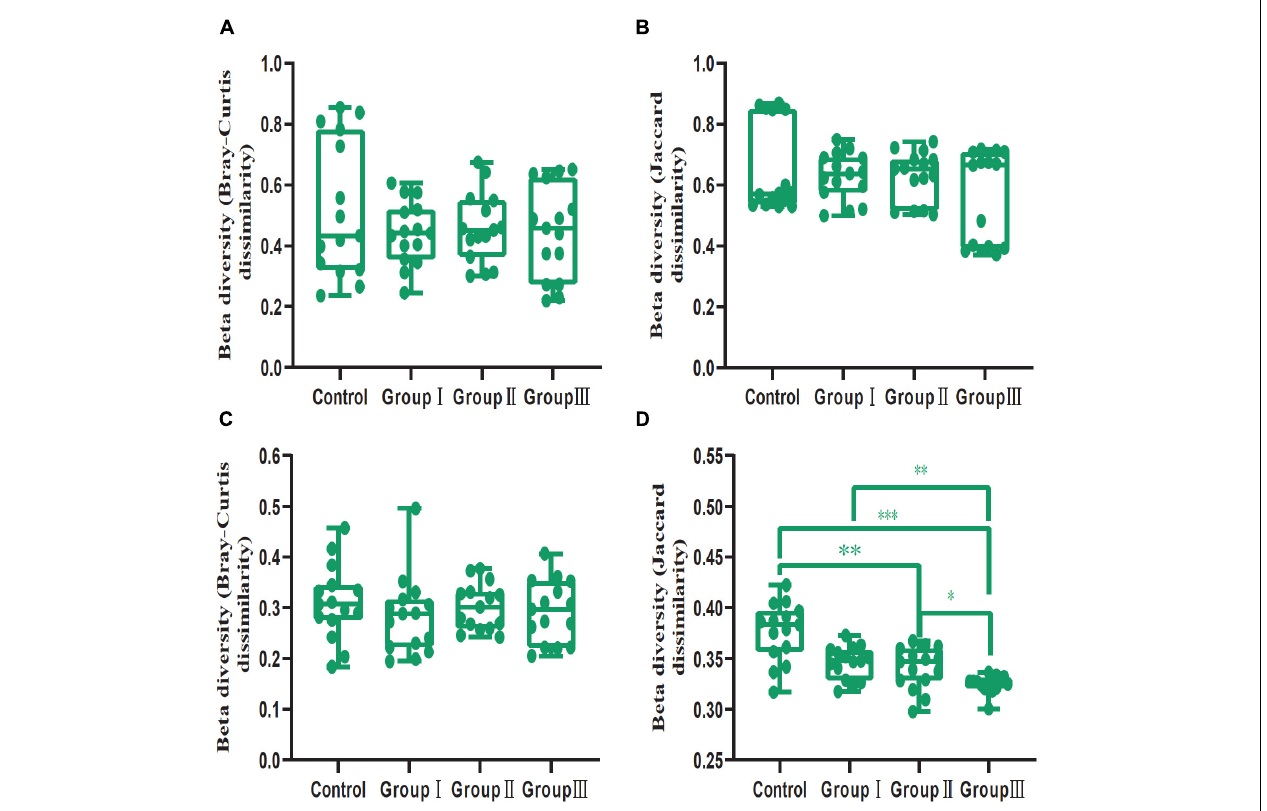
FIGURE 4 | Comparison of β -diversity (Bray-Curtis and Jaccard dissimilarities within each dietary fiber groups) values between the four dietary fiber groups in the jejunum (A,B) and cecum (C,D) . Differences were assessed using the Wilcoxon test and are denoted as follows: * P < 0.05; ** P < 0.01; *** P < 0.001.